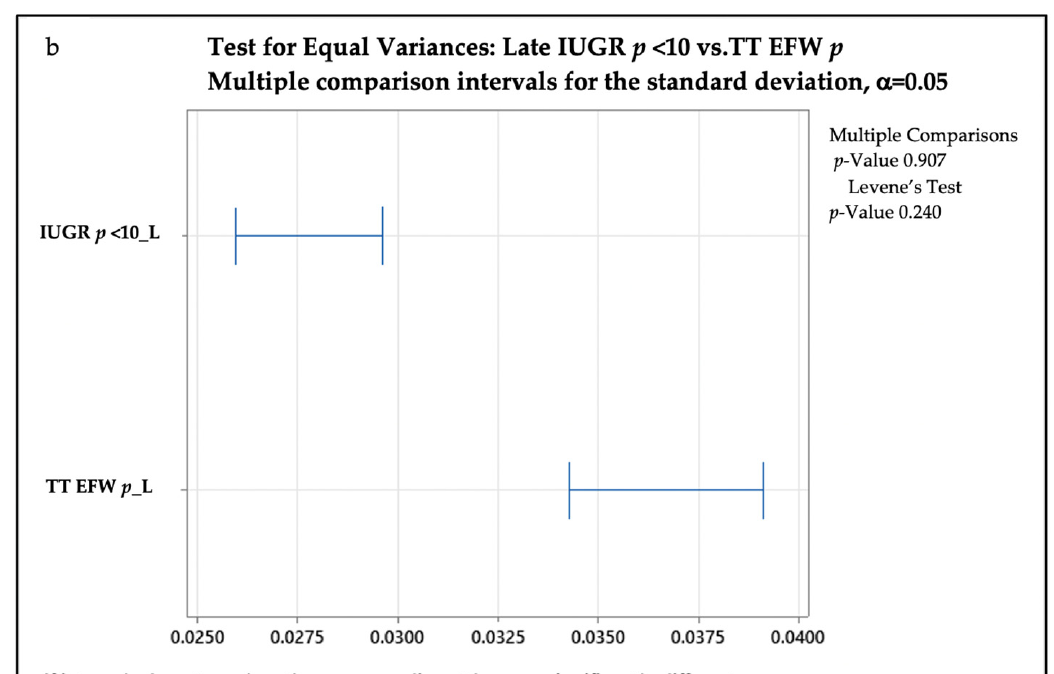
Figure 2. A graphic presentation of the test for equal variance to compare the estimated fetal weight percentile and birth percentile: ( a ) the test for equal variance to compare the estimated fetal weight percentile and birth percentile in the Eo-IUGR group; ( b ) the test for equal variance to compare the estimated fetal weight percentile and birth percentile in the Lo-IUGR group. Abbreviations: IUGR — intrauterine growth restriction; TT — third trimester; EFW — estimated fetal weight; p — percentile; stdevs — standard deviations.